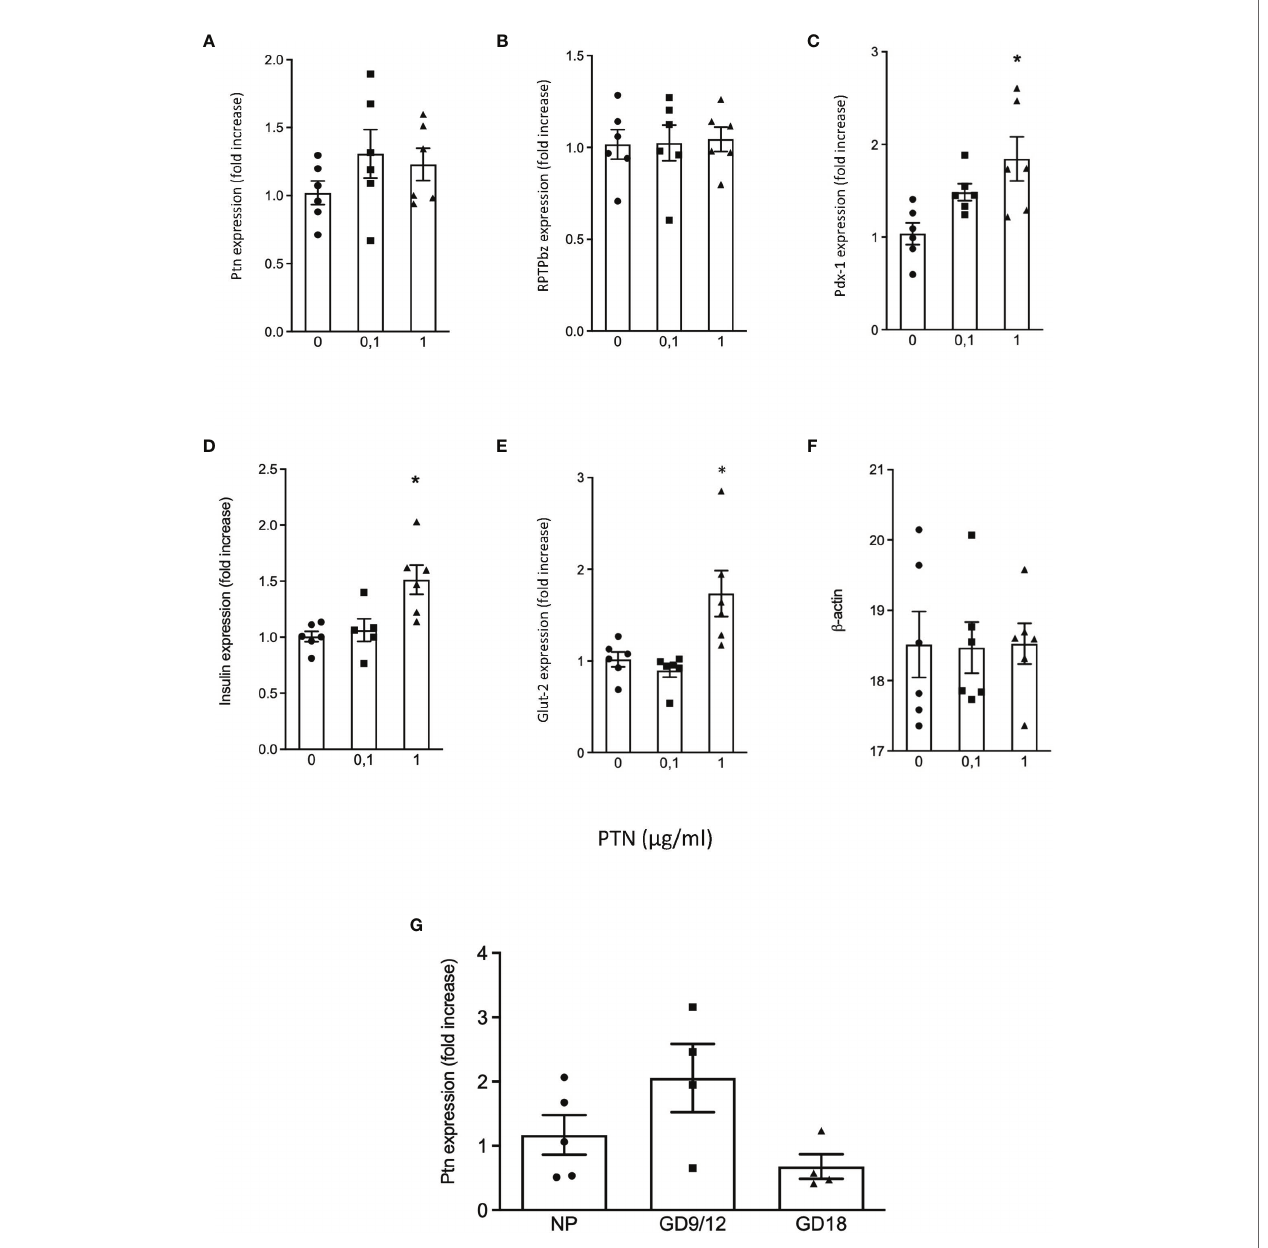
FIGURE 1 | Quanti fi cation of mRNA expression in INS1E cells treated without or with 0.1 m g/ml or 1 m g/ml PTN. Fold change vs. control without PTN for (A) Ptn , (B) Ptprz1 (RPTP b / z ), (C) Pdx1 , (D) Ins (insulin), (E) Glut2 and (F) b actin which served as a ‘ housekeeping ’ gene. *p < 0.05 vs. control (n=6). The relative expression of Ptn in adult mouse pancreas in non-pregnant mice, and pregnant mice at GD 9/12 and at GD 18 is shown in (G) ,